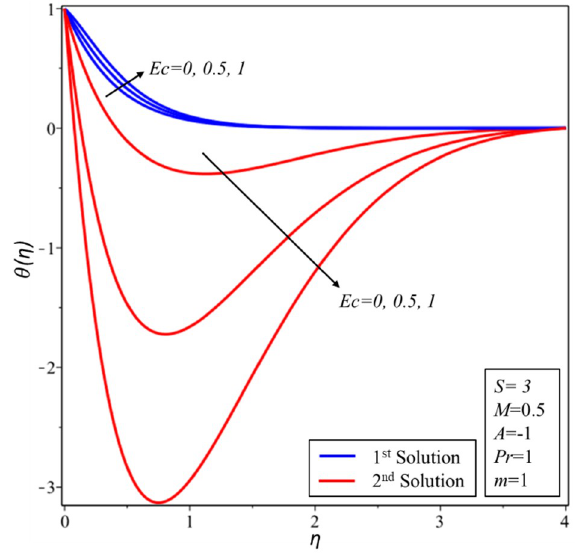
Figure 6. θ(η) for increasing values of Ec and α = 1.